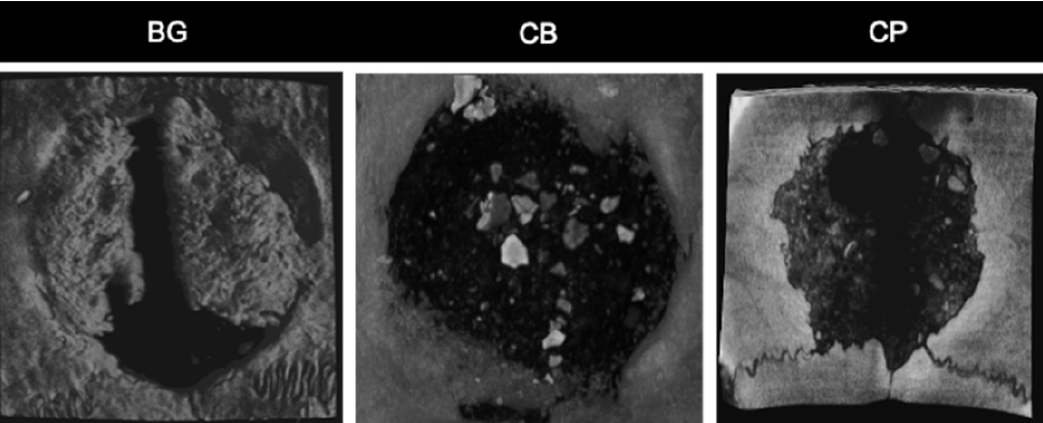
Figure 7. Axial reconstruction of the critical defect in the cap of the animals after 60 days of bone repair, for groups BG, CB and CP. The largest area of bone neoformation is observed in the BG group, followed by the CB group (with the presence of hydroxyapatite granules) and finally the CP group. Regarding the trabecular bone, for the average Tb.th, the BG (0.250 mm) and